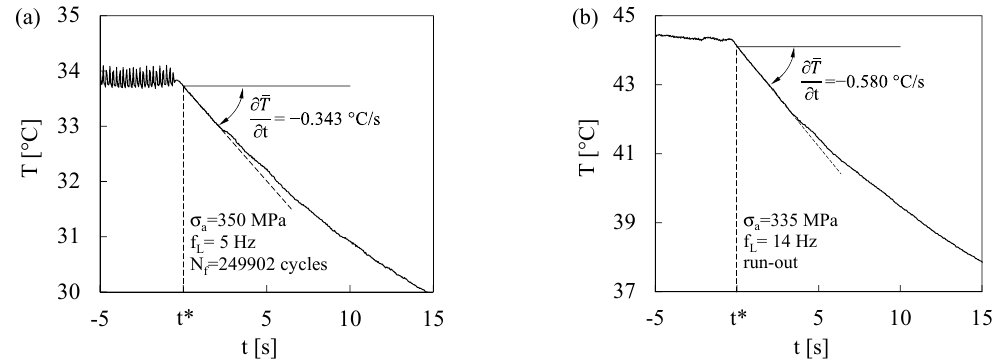
Figure 10. Typical cooling gradients measured during the staircase fatigue tests: ( a ) σ a = 350 MPa, f L = 5 Hz, N f = 249,902 cycles; ( b ) σ a = 335 MPa, f L = 14 Hz, run-out.